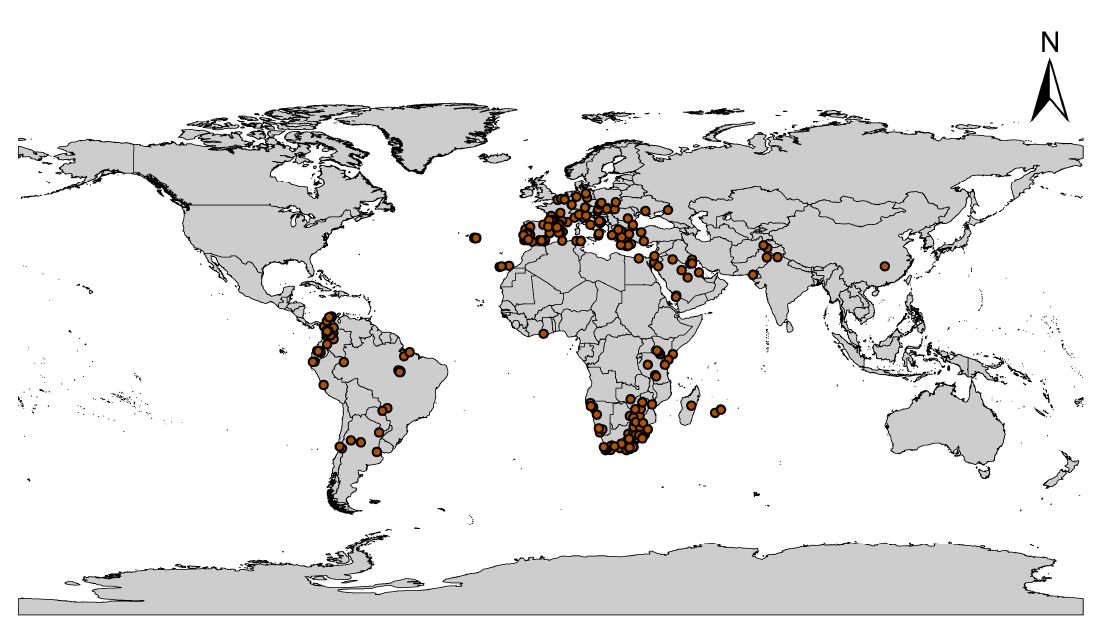
Figure 1. Observed distribution of C. albiceps